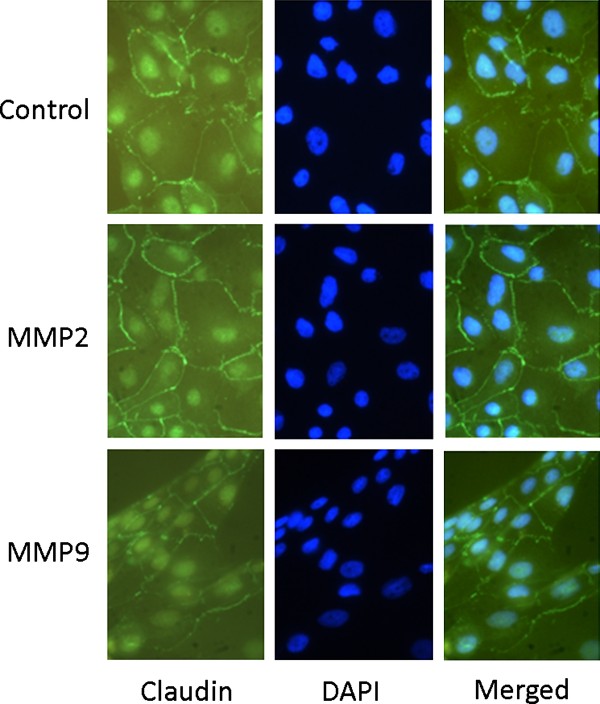
Immunofluorescent microcopy of pleural mesothelial cells treated or not with MMP2 and MMP9 using an anti-claudin-1 antibody. Control cells displayed a continuous staining at cell periphery. The same pattern occurred also for cells treated with MMP2 or MMP9. Nuclei were stained with Dapi.